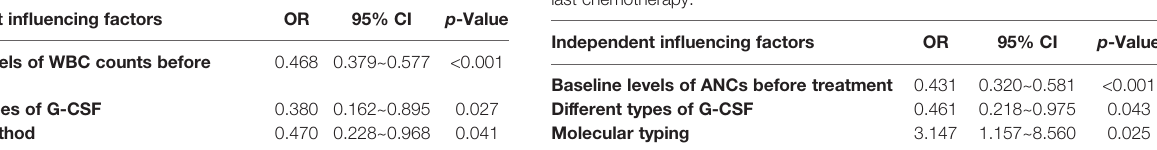
TABLE 5 | Multivariate logistic regression model estimates of independent in fl uencing factors for neutropenia in the 12th month after the end of the last